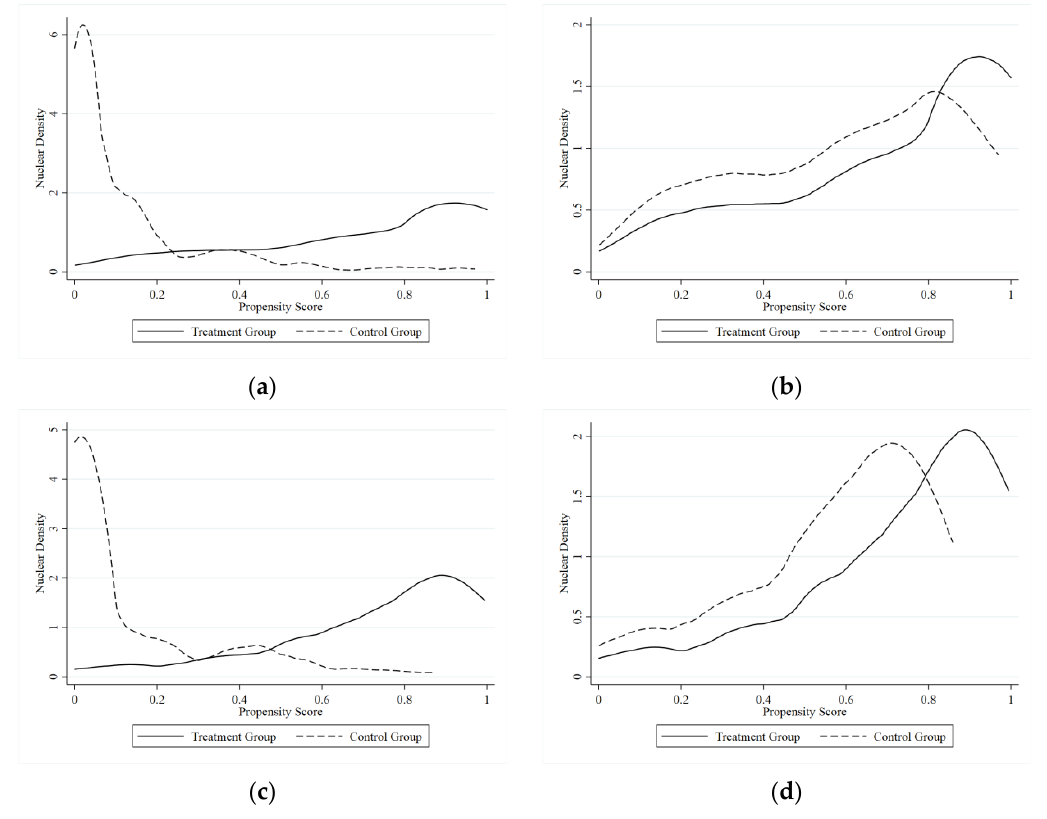
Figure 3. Kernel Density Function of Propensity Score. ( a ) Samples before matching in Tanglang Village Committee of Tanglang Township; ( b ) Samples after matching in Tanglang Village Committee of Tanglang Township; ( c ) Samples before matching in Dache Village Committee of Zehei Township; ( d ) Samples after matching in Dache Village Committee of Zehei Township. Table 9. Average Treatment Effect on the Treated (ATT) of Promoting Sorghum Planting